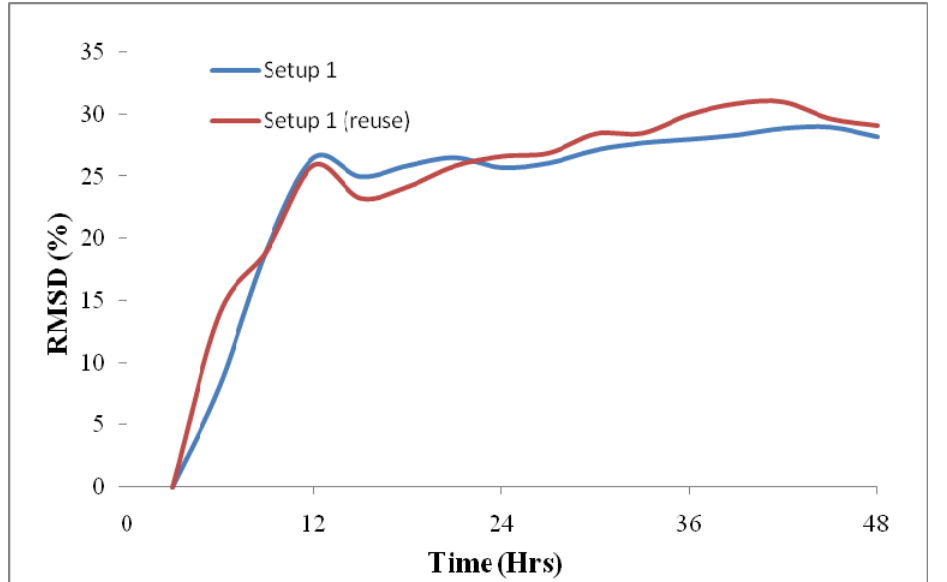
Figure 12. Repeatability of RMSD for same mix